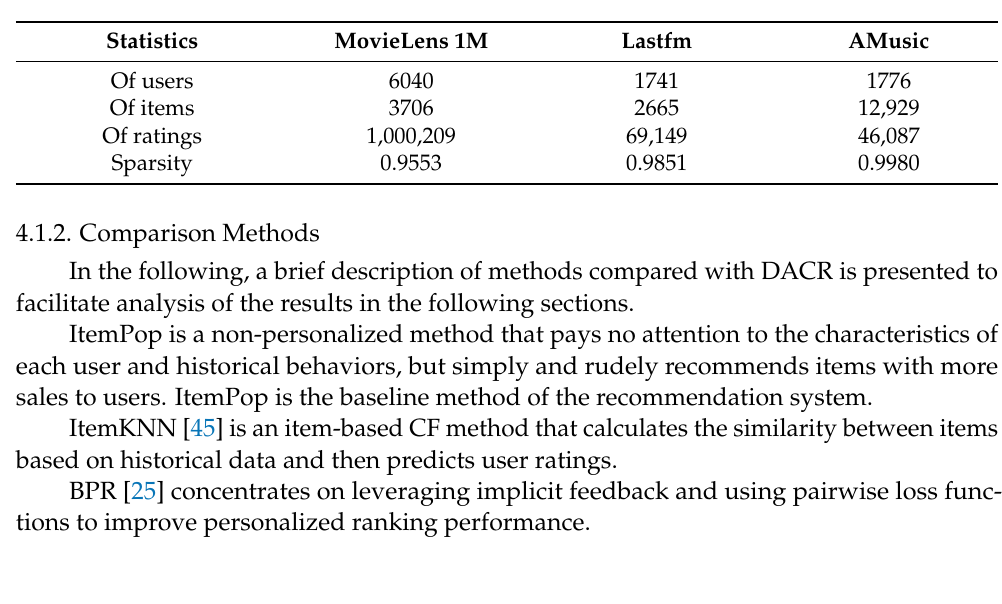
Table 1. Statistics of the